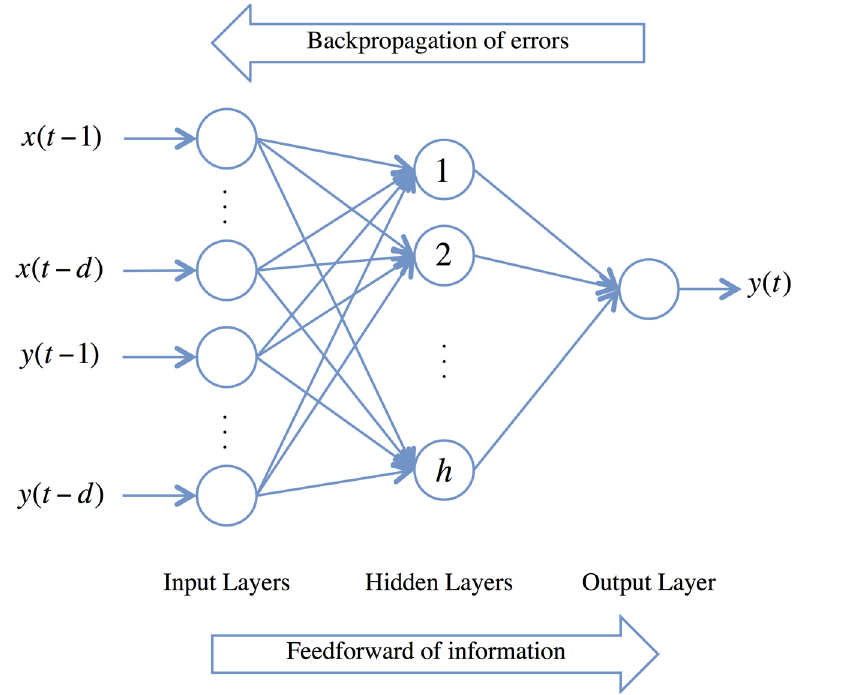
Fig 1. Feedforward Backpropagation Neural Network